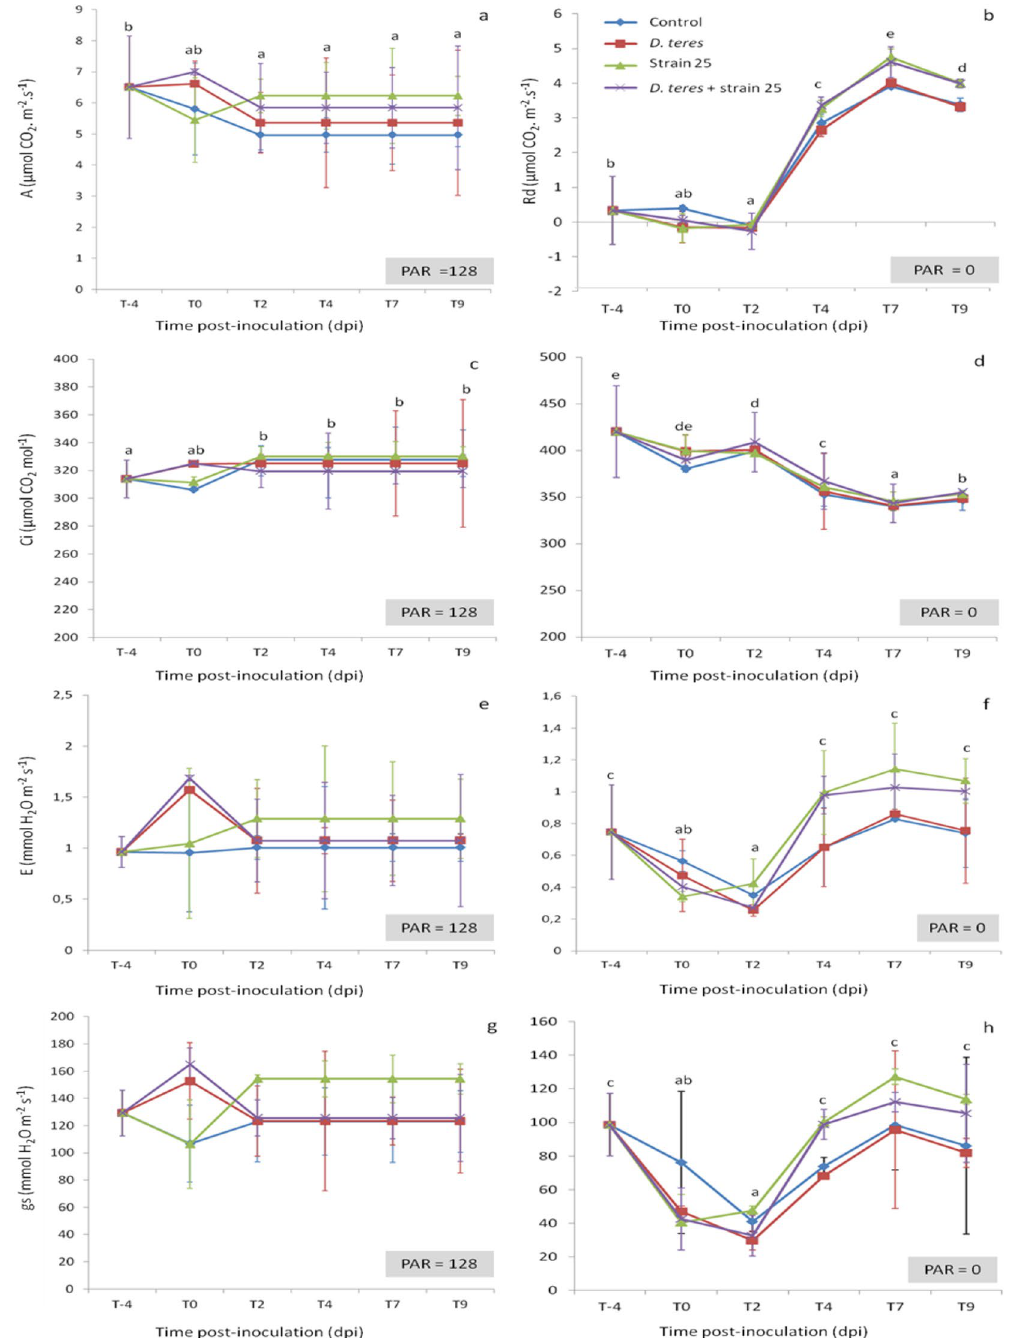
Figure 5. Changes in net carbon assimilation rate ( A ) in day condition ( a ), dark respiration ( Rd ) ( b ), internal CO 2 concentration ( C i) in day condition ( c ) and in night condition ( d ), transpiration rate ( E ) in day condition ( e ) and in night condition ( f ) and stomatal conductance ( g s) in day condition ( g ) and in night condition ( h ) determined on the leaflets of barley plants non-inoculated (control) or inoculated ( D. teres ) or bacterized with strain B25 or inoculated and bacterized ( D. teres + B25). The measurements were carried out in the first barley leaf 4 days before inoculation (T-4) with D. teres and 0, 2, 4, 7 and 9 dpi noted T2, T4, T7 and T9, respectively. Bars represent the standard error of the means, calculated from three independent experiments for each experimental condition and for each time-point, n = 15. Different letters indicate statistically different means (Student’s test; p value < 0.05) between times